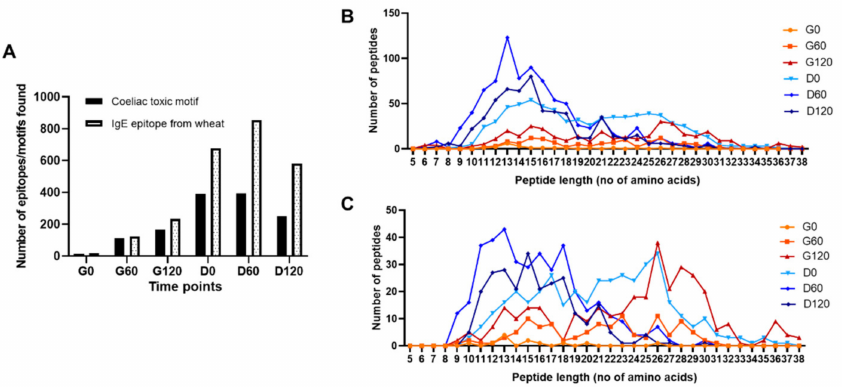
Figure 5. Bioaccessible wheat-derived peptides carrying IgE epitopes and coeliac toxic motifs in pizza base digests. ( A ) The number of non-unique IgE epitopes and coeliac toxic motifs found within identified peptides attributed to wheat throughout simulated digestion. ( B , C ) Length distribution of wheat peptides found containing non-unique IgE epitopes ( B ) and coeliac toxic motifs ( C ) throughout simulated digestion. Digestion time points are as described in Figure